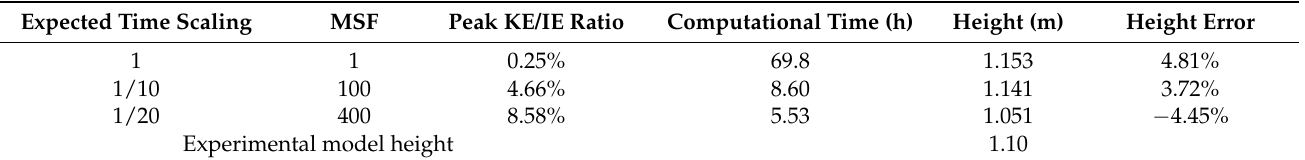
Table 4. Time consumption, peak KE/IE ratio, empty airbag height, and height errors with respect to experimental height of 1.10 m under different MSFs during the deflation process.